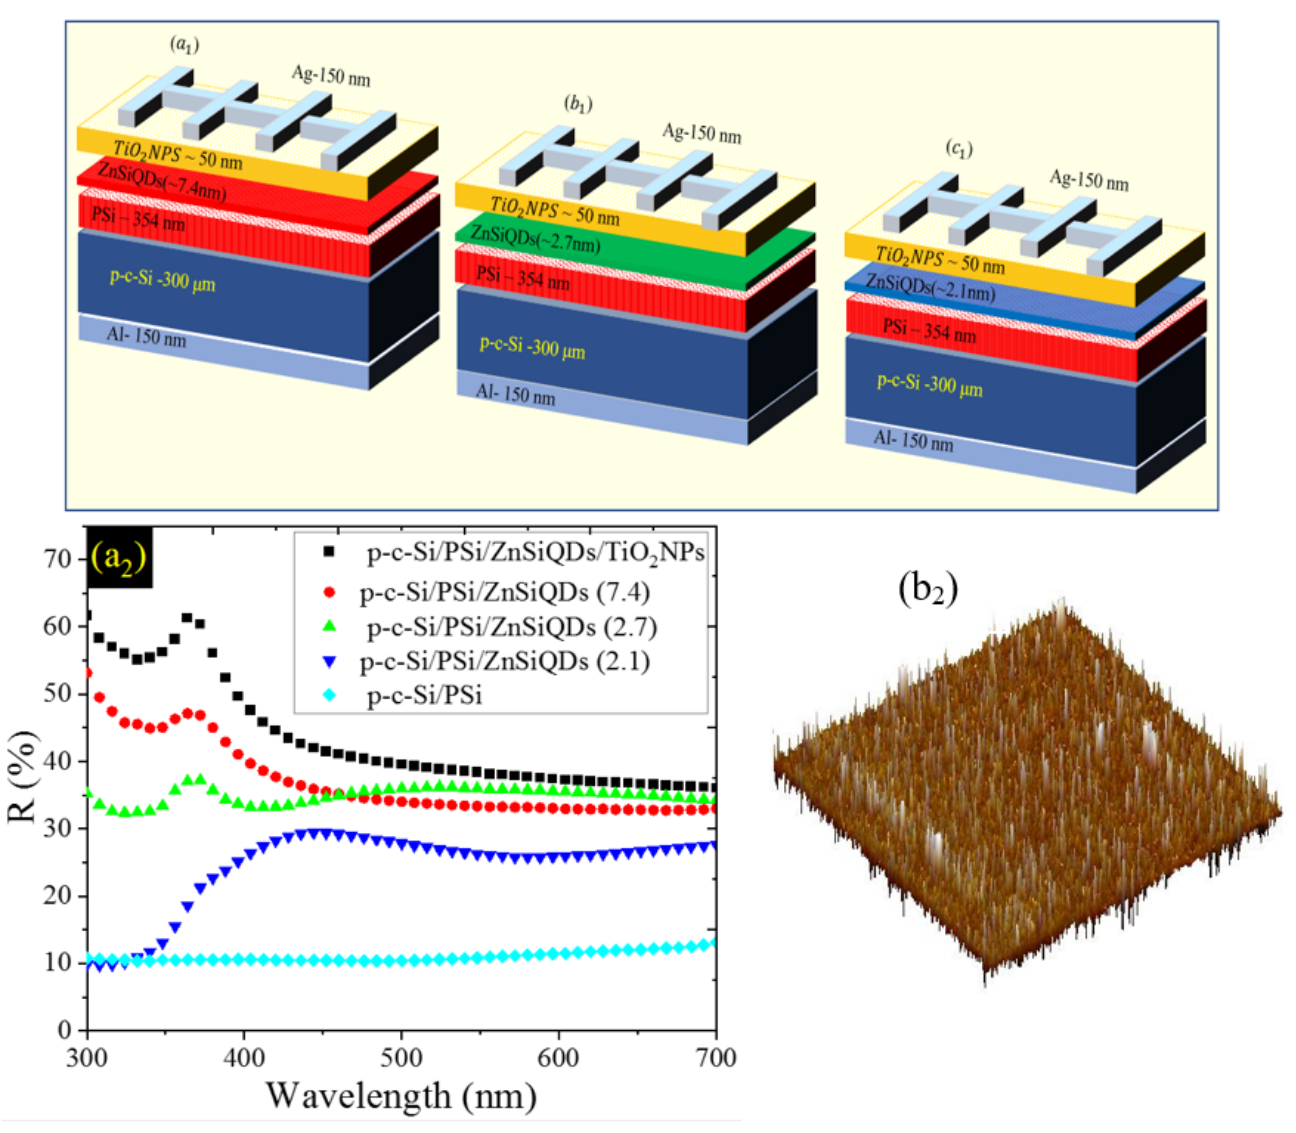
Figure 6. Architectures of the GBQDSCs ( a 1 ) Al/p-c-Si/PSi/ZnSiQDs/TiO 2 NPs/Ag (ZnSiQDs mean size of 7.4 nm), ( b 1 ) Al/p-c-Si/PSi/ZnSiQDs/TiO 2 NPs/Ag (QDs mean size of 2.7 nm) and ( c 1 ) Al/p-c-Si/PSi/ZnSiQDs/TiO 2 NPs/Ag (QDs mean size of 2.1 nm). ( a 2 ) Reflection spectra of p-c-Si/PSi, p-c-Si/PSi/ZnSiQDs (ZnSiQDs mean size of 7.4 nm), p-c-Si/PSi/ZnSiQDs (QDs mean size of 2.7 nm) and p-c-Si/PSi/ZnSiQDs (QDs mean size of 2.1 nm), and ( b 2 ) AFM scan of 10 × 10 μ m area at 1 Hz image of p-c-Si/PSi/ZnSiQDs (2.1 nm)/TiO 2 NPs (RMS roughness of 0.859 nm).